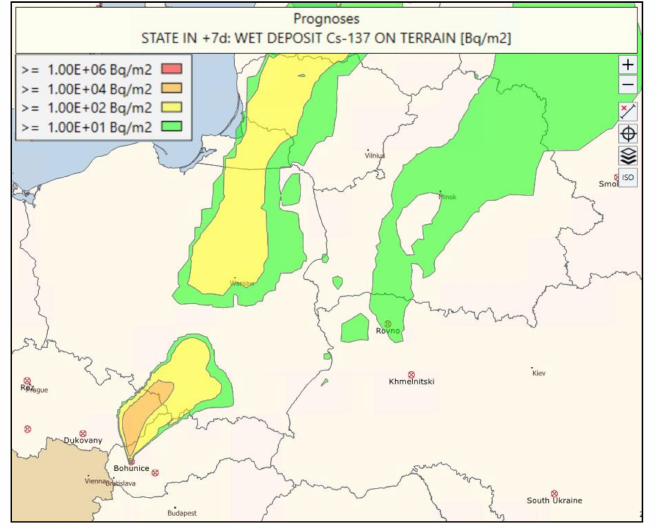
Figure 5. Wet deposit of Cs-137 in +7 days from the time of release. The deposit is a result of the release of 1 × 10 15 Bq of Cs-137 from Bohunice NPP, at 10:00 UTC on 9 November